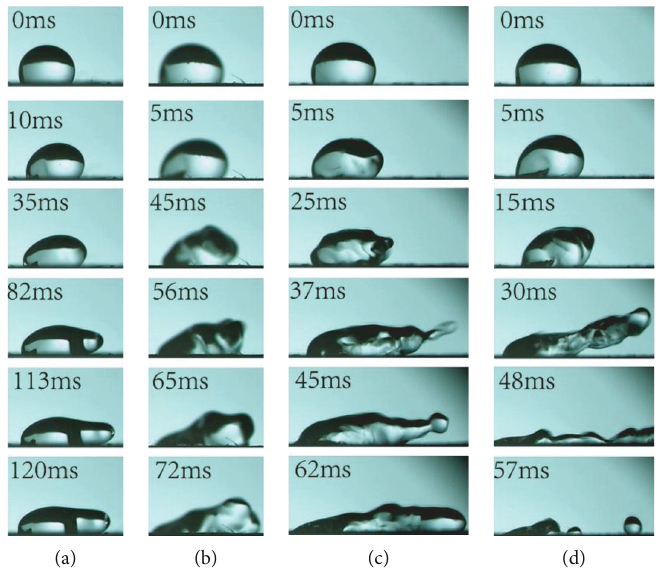
Figure 14: The movement of 8 μ L droplet on GDL surface under di ff erent air velocities.